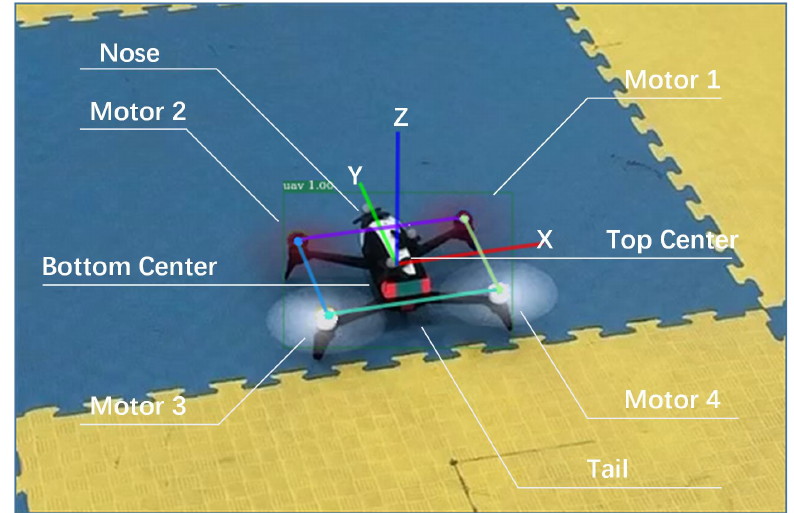
Figure 1. Parrot Bebop-2 quadrotor and the definition of its eight